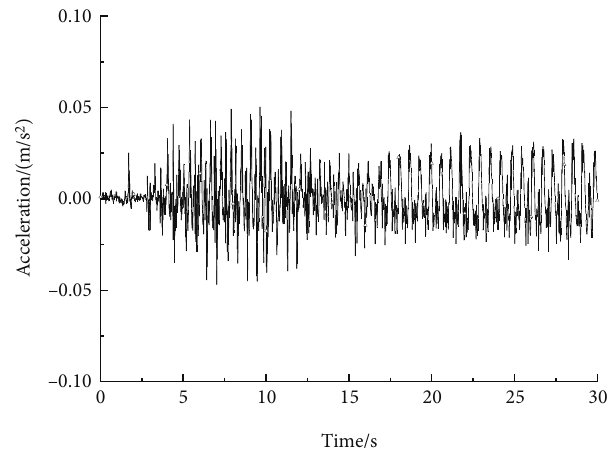
Figure 9: Tip acceleration test curve of the patient transfer device. Table 4: Maximum tip acceleration comparison between simulation and experiment (m/s 2